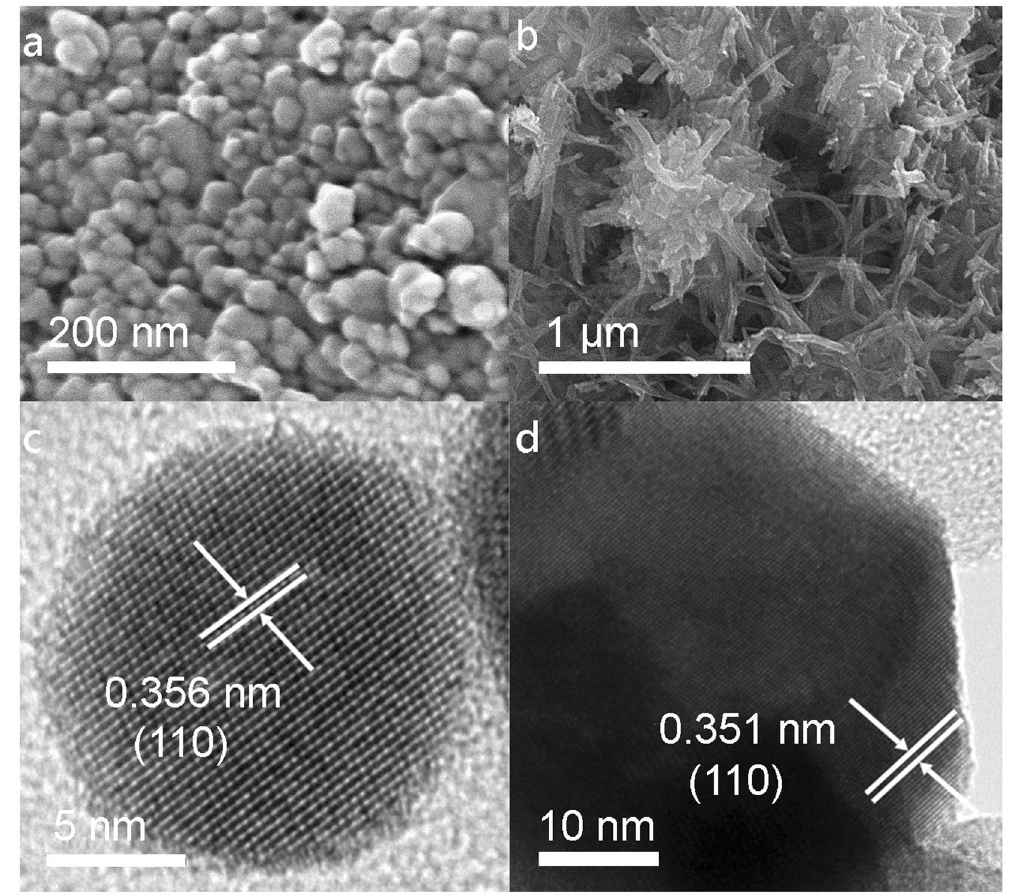
Figure 1. SEM and TEM images showing the Ta 3 N 5 precursor nanoparticles ( a and c , respectively) and the Ta mean diameter 32 ± 9 nm.